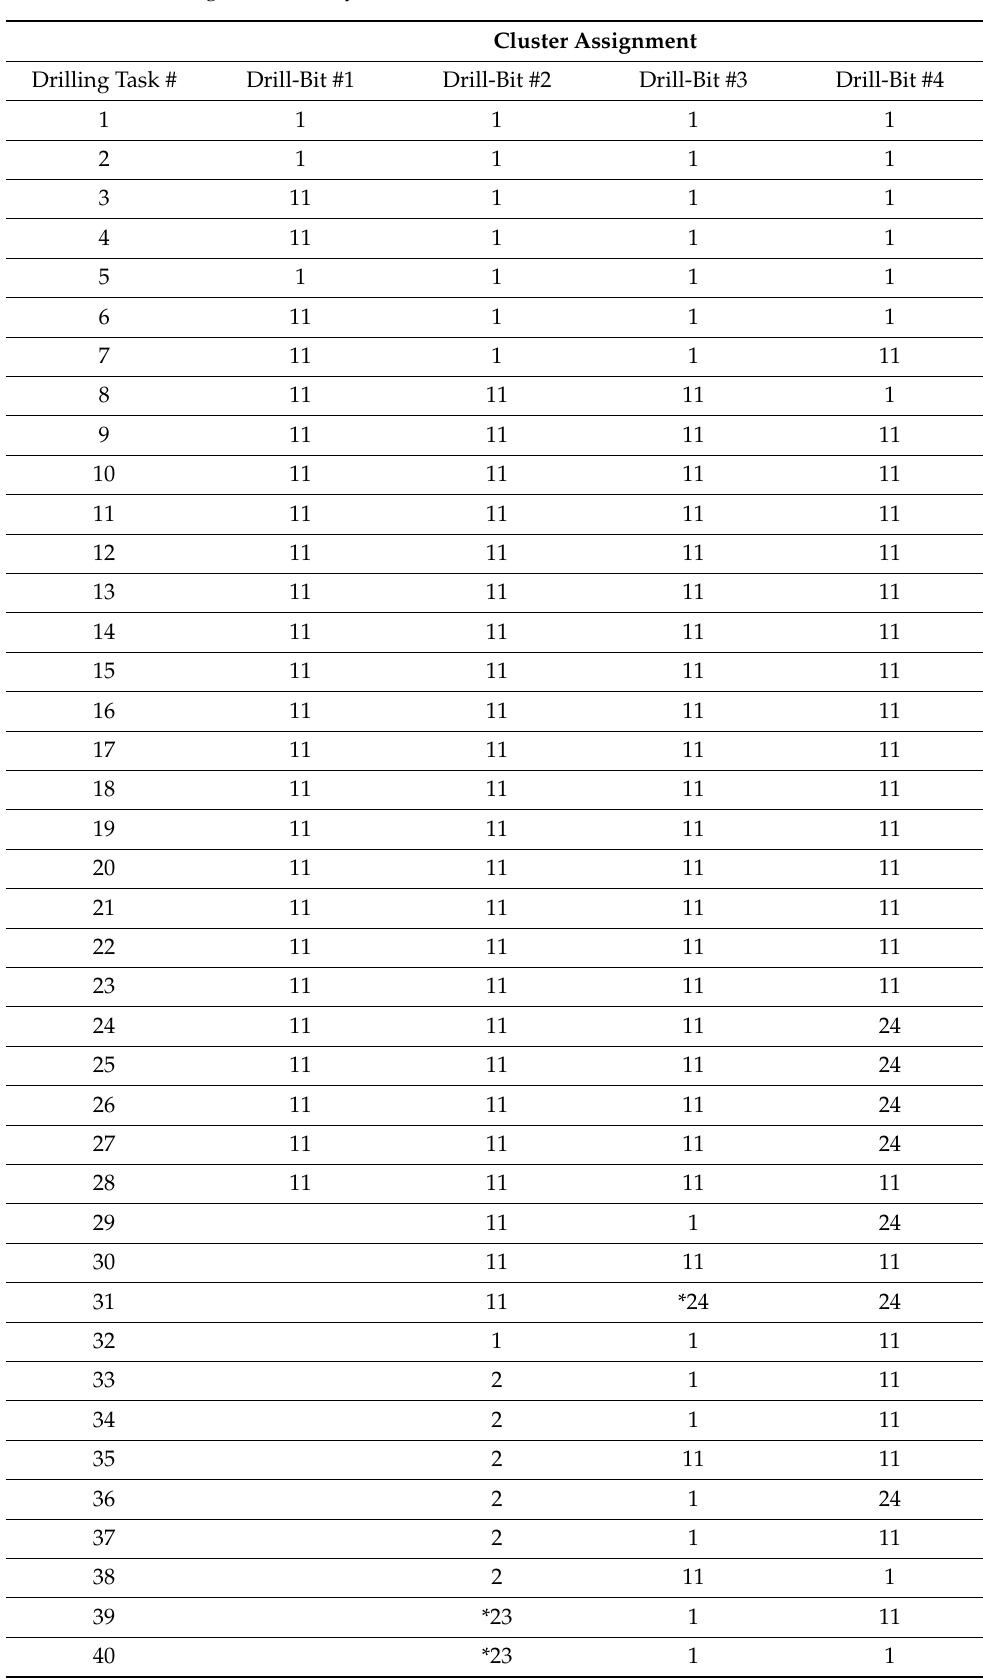
Table 2. Cluster assignment history of drill-bits #5 ~